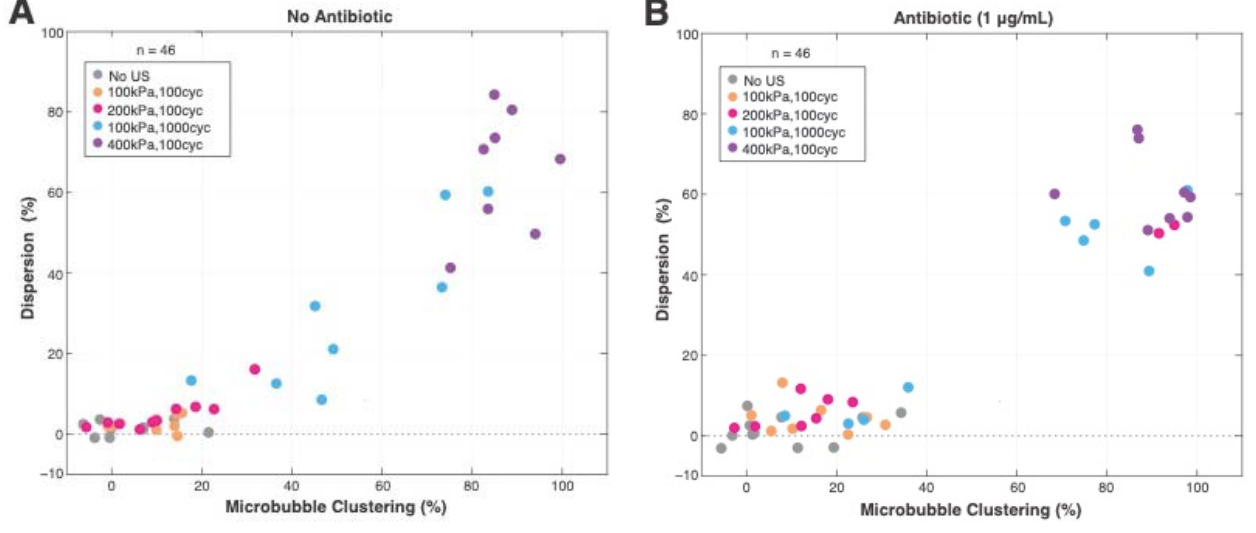
Figure 8. Microbubble clustering used as a measure of microbubble displacement corresponding to bacterial dispersion (Equation (4); microbubble clustering (%)) following insonification without an antibiotic ( A ) and with an antibiotic ( B ) present. cyc = cycles; US =